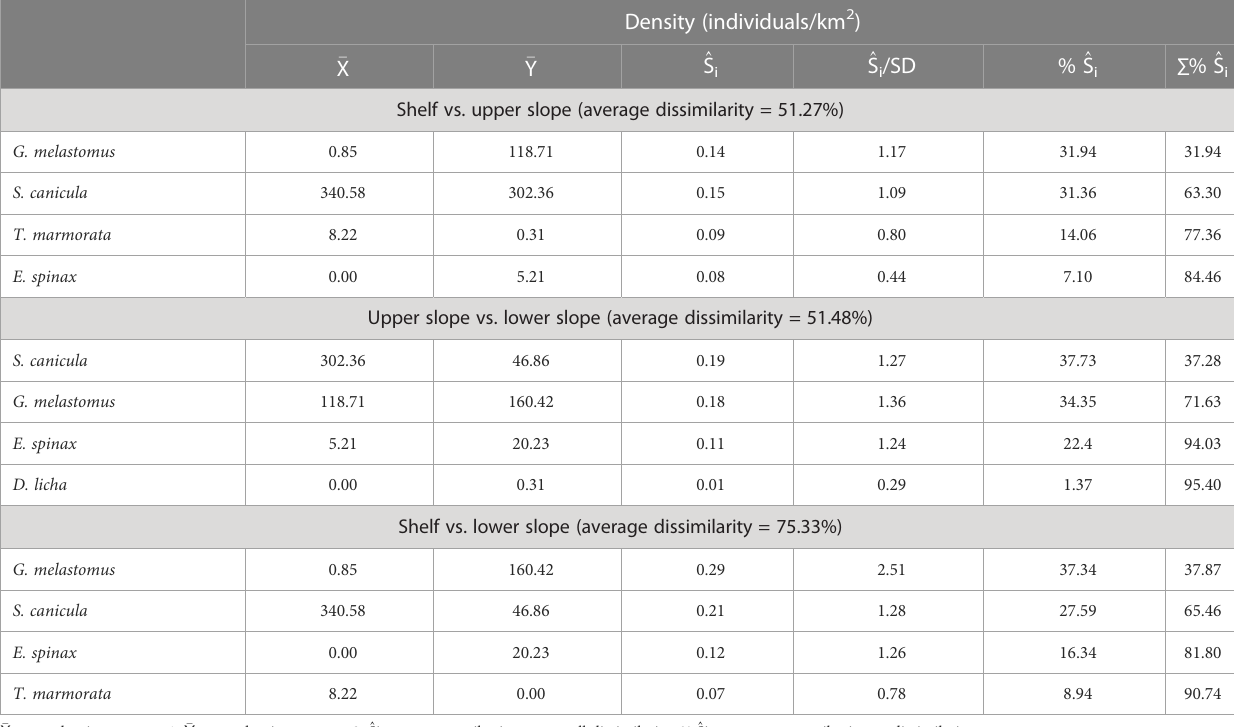
TABLE 4 Similarity percentages (SIMPER) analysis results for the comparison of the assemblages (continental shelf, upper slope, and lower slope) identi fi ed from principal coordinates analysis.